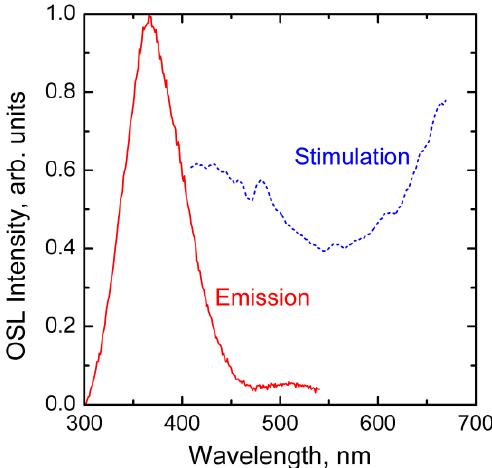
Figure 2. OSL emission and stimulation spectra of AlN ceramic. These spectra were measured after the sample was irradiated with 10 Gy of X-rays. The emission spectra were obtained by stimulation at 630 nm whereas the stimulation spectra were obtained by monitoring the emission at 360 nm.